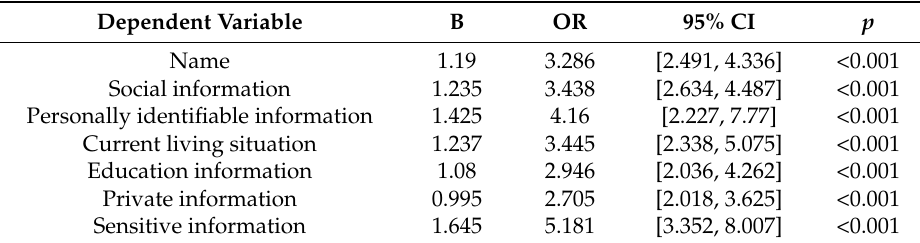
Table 2. Doxing as predictor of disclosure of others’ personal information.